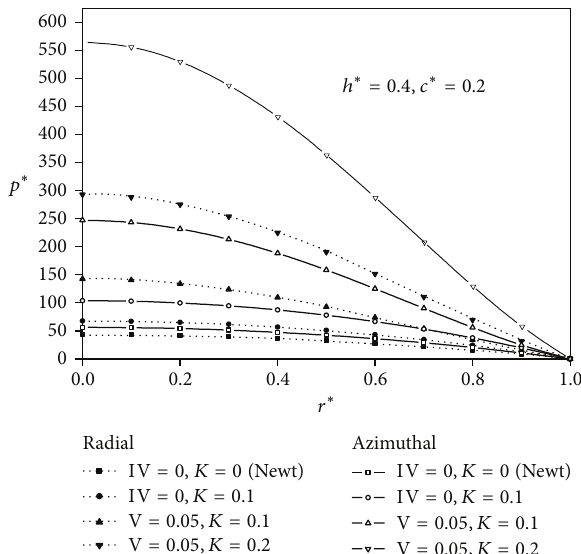
𝑝 ∗ versus radial coordinate 𝑟 ∗ for different 𝑐 ∗ .